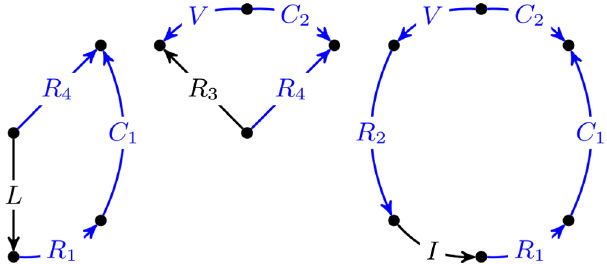
FIG. 8. Loops formed by adding a particular link to the normal